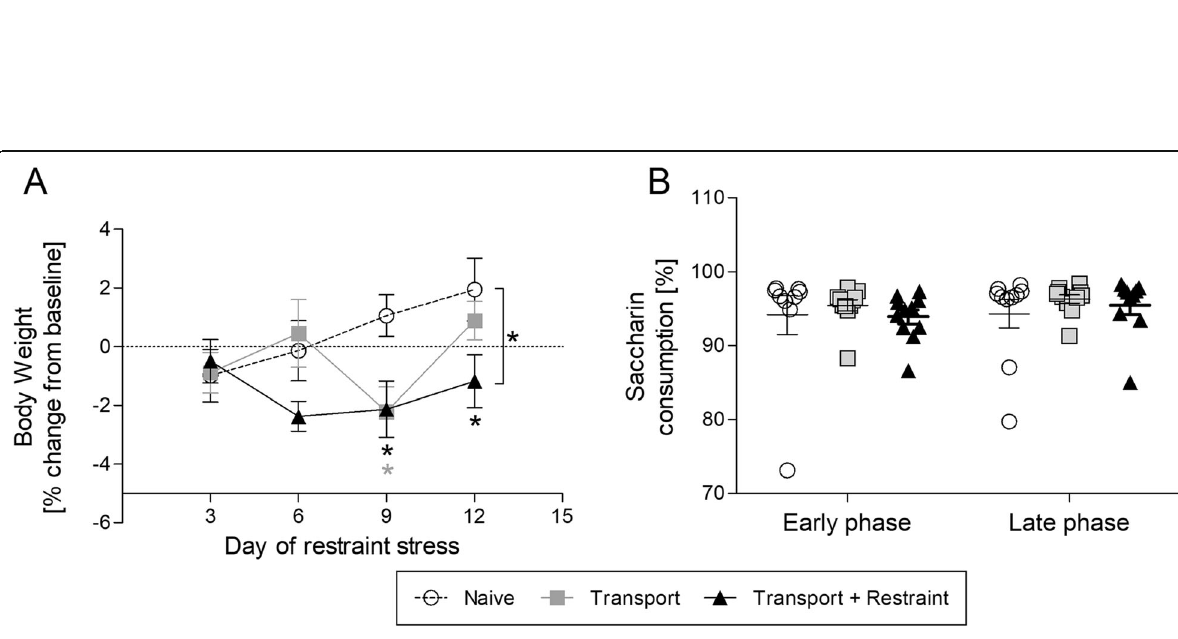
Fig. 3 Influence of transport and combined transport and restraint on body weight and saccharin preference. b Time course of body weight development illustrated as mean percent change from baseline. b Percentage of saccharin consumption in the early phase (day 3-6) and the late phase (day 9-12) of the study. Data are shown as mean ± SEM. * P <